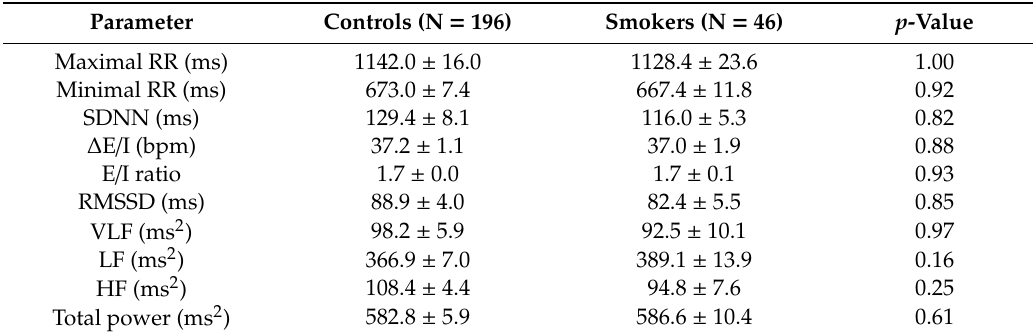
Table 3. Values of deep breathing test (DBT) characteristics in smokers and nonsmokers. Parameter Controls (N = 196)